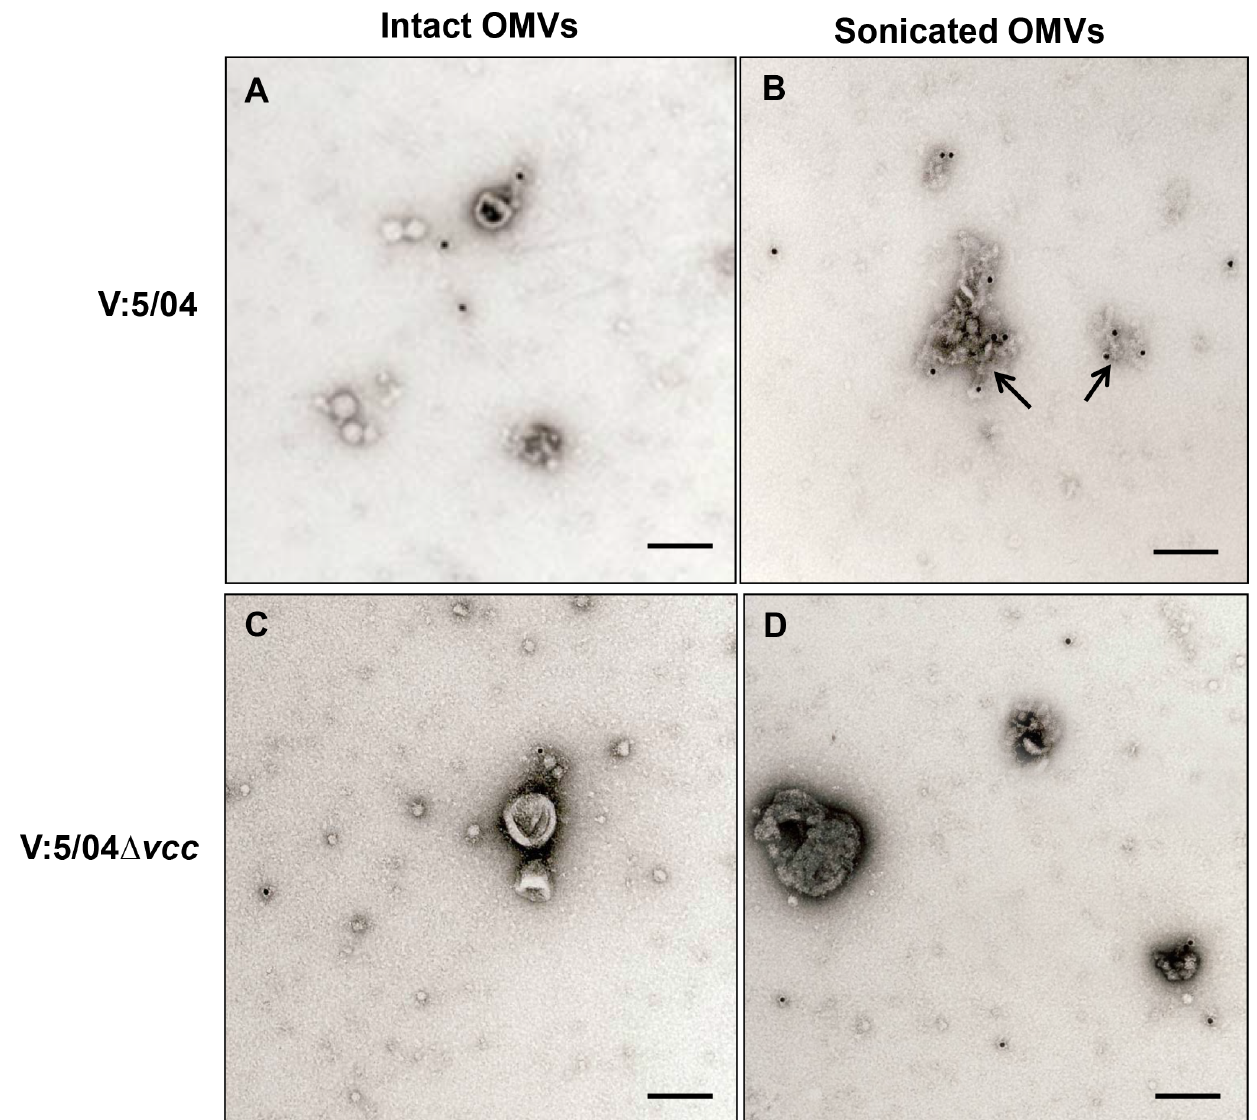
Figure 4. Immunoelectron microscopic detection of VCC in OMVs. Immunogold-labelling was performed with OMVs from wild type NOVC strain V:5/04 (A–B) and the D vcc mutant (C–D). Tests were done both with intact vesicles (A, C) and with vesicles ruptured by sonication (B, D). Arrows indicate gold particles associated with OMVs. Bars; 100 nm.